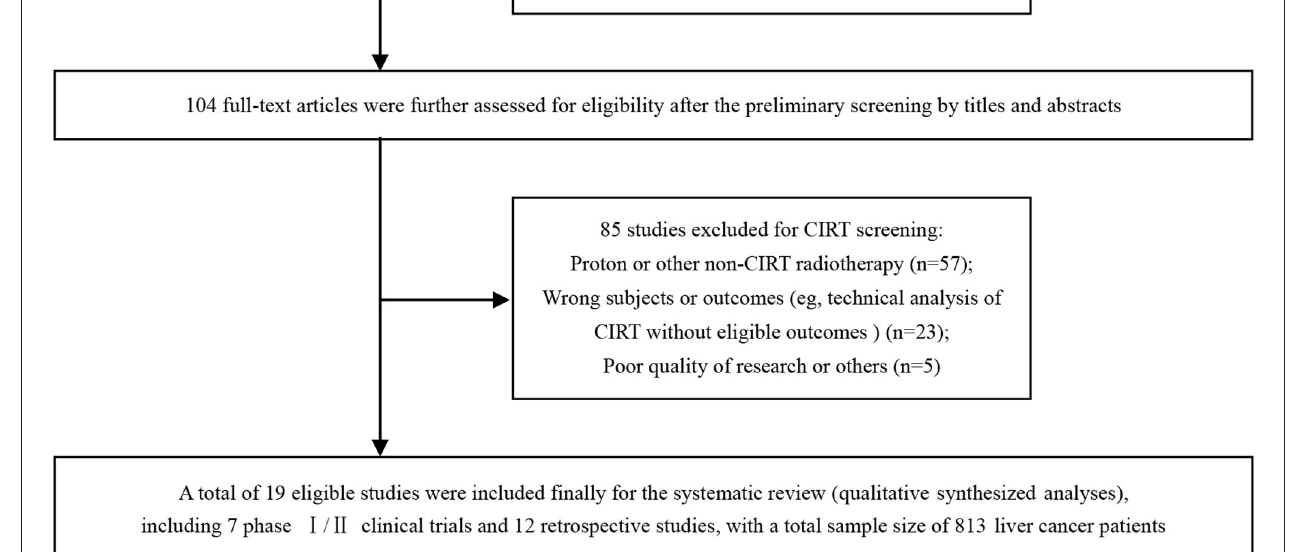
6 cm chemo-resistant metastatic liver tumor from breast cancer was successfully cured with a single shot of 36-GyE CIRT, and the woman survived more than 8 years without local recurrence